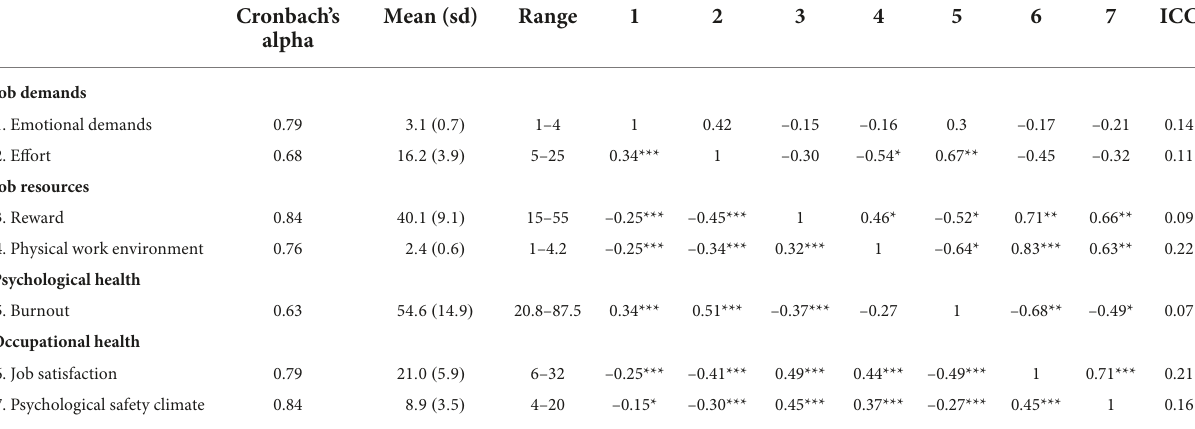
TABLE 3 Internal consistencies, means, standard deviations, correlations between study variables, and intra-class coefficients (ICCs).